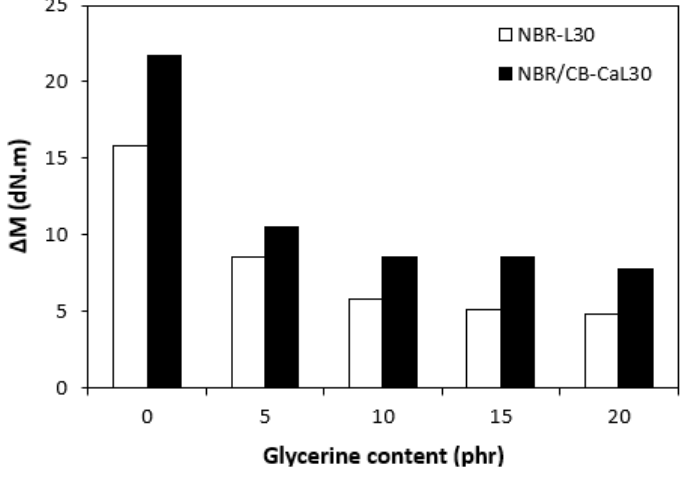
Figure 5. Influence of glycerine contents on torque differences ΔM of rubber compounds.